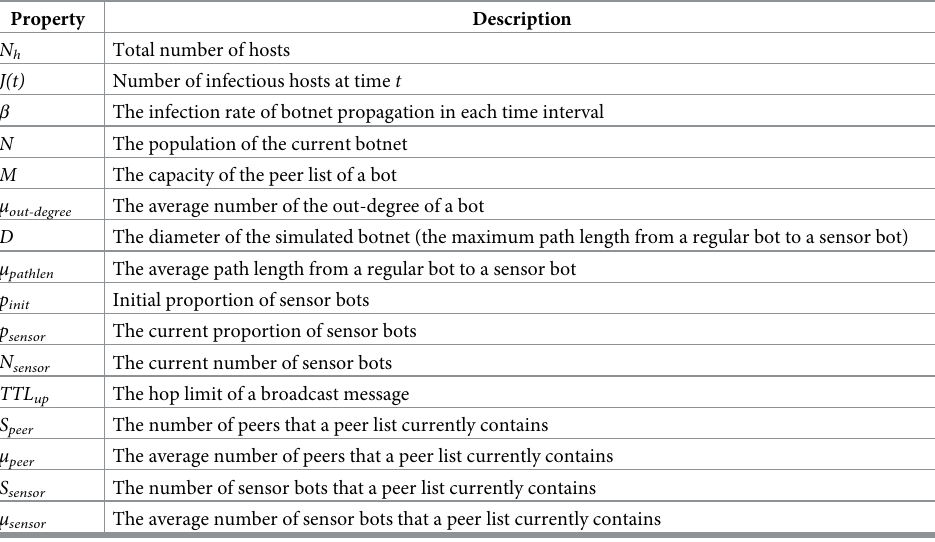
Table 1. The definition of network properties.